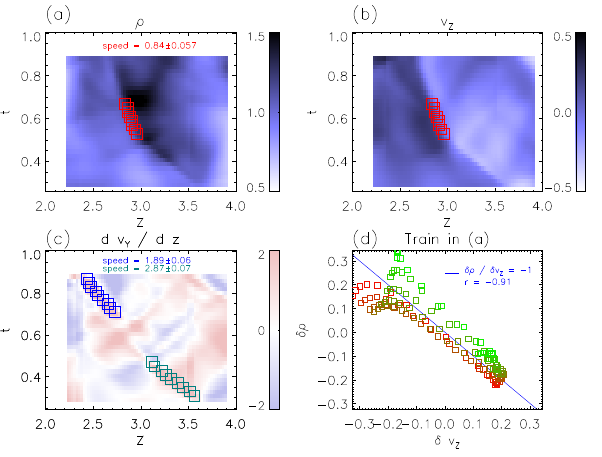
Figure 9. Features of slow wave case 3, in the same format as Fig. 5. Figure 10. Features of slow wave case 4, in the same format as Fig. 5. In (a) and (b) , tracked points are maxima of | ∂ρ/∂z |